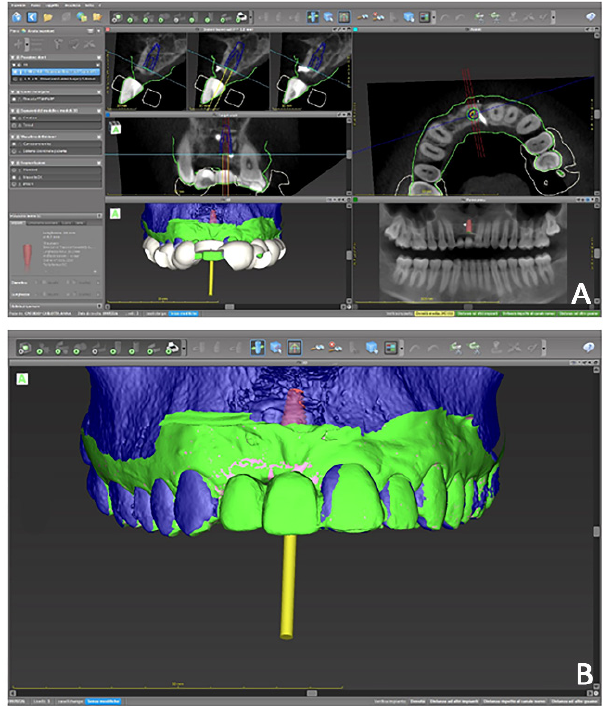
Figure 9. Case 2. Digital planning of implant placement and design of surgery guide. ( A ) Multiple 2D and 3D view; ( B ) 3D prosthetically guided implant surgery simulation.